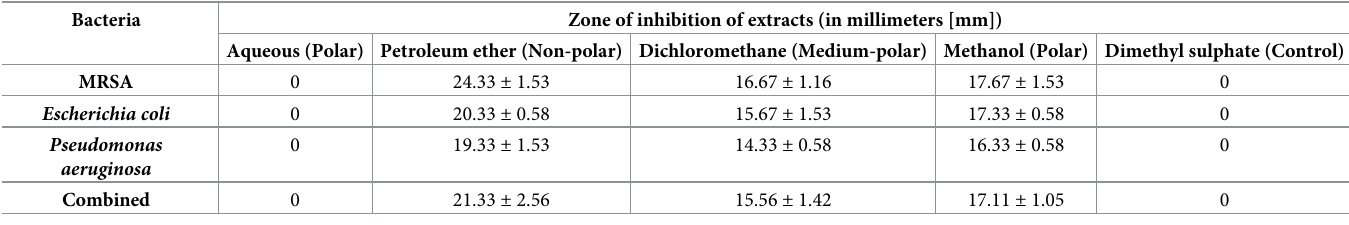
Table 1. Zones of inhibition of leaf extracts of Eucalyptus grandis on selected microorganisms.